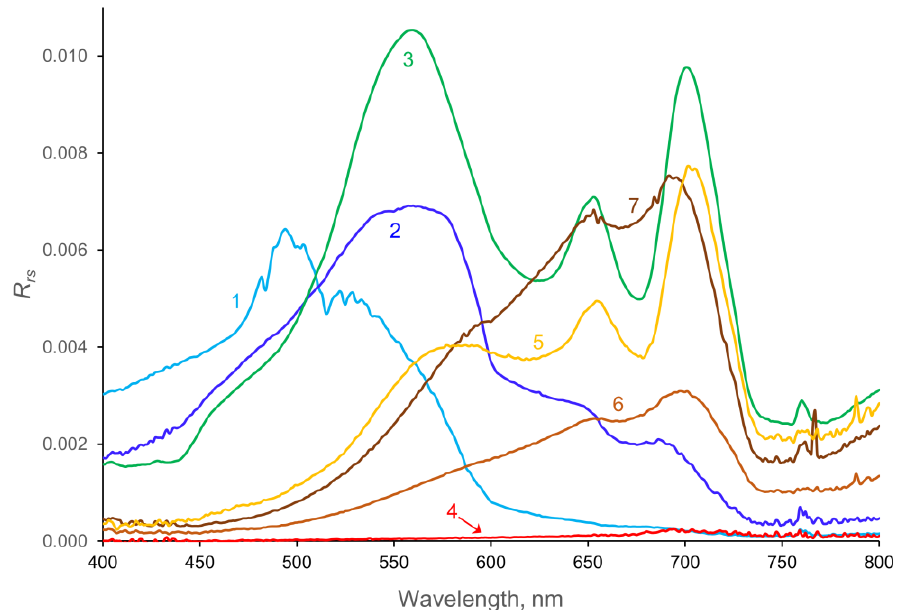
Figure 5. Reflectance spectra for water bodies dominated by various optical properties: (1) nearly pure water (Sabin Lake); (2) clear, oligotrophic water (Woman Lake); (3) chlorophyll (Halstead’s Bay); (4) CDOM (Section Eleven and Johnson Bog); (5) CDOM and chlorophyll (Big Sandy Lake); (6) CDOM and SM (Flowage Lake); (7) SM and CDOM (St. Louis River).